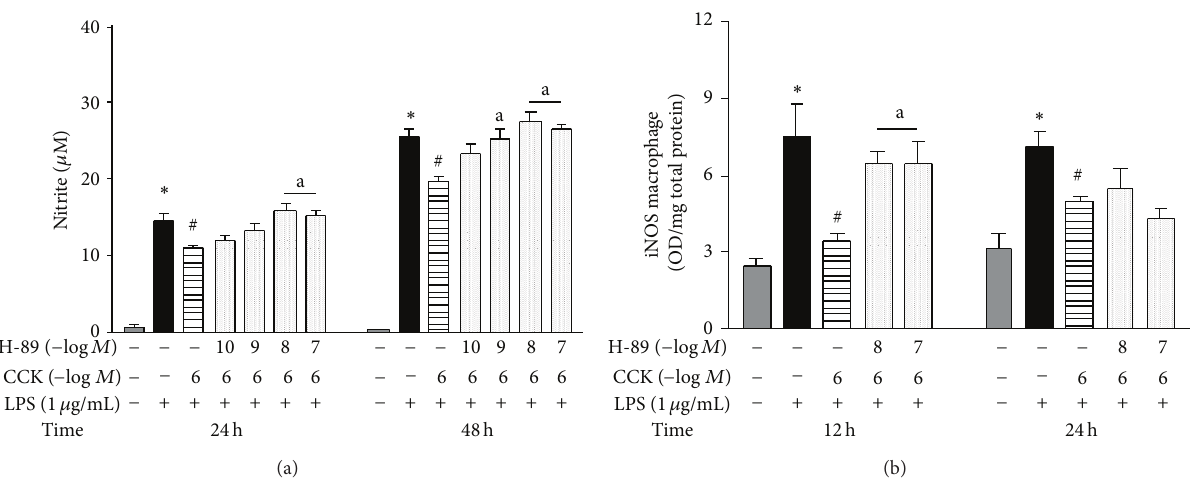
Figure 5: High CCK concentration activates PKA pathway which attenuates LPS-induced iNOS expression by peritoneal macrophages. To associate changes on intracellular cAMP and PKA activation with LPS-induced iNOS expression, the macrophage culture was incubated with PKA inhibitor (H-89) (10 −10 –10 −7 M) for 30 min before the addition of CCK at 10 −6 M (a and b). Thirty minutes later, cells were stimulated by LPS (1 𝜇 g/mL) (time zero). The culture supernatant was collected for nitrite quantification by Griess method (a) and the iNOS synthesis was determined in cell lysates by ELISA (b). Data is a representative of three independent experiments with similar results. Values are expressed as means ± S.E.M. 𝑛 = 4–12 samples per group. ∗ 𝑃 < 0.05 versus saline, # 𝑃 < 0.05 versus LPS, and 𝑎 𝑃 < 0.05 versus respective CCK